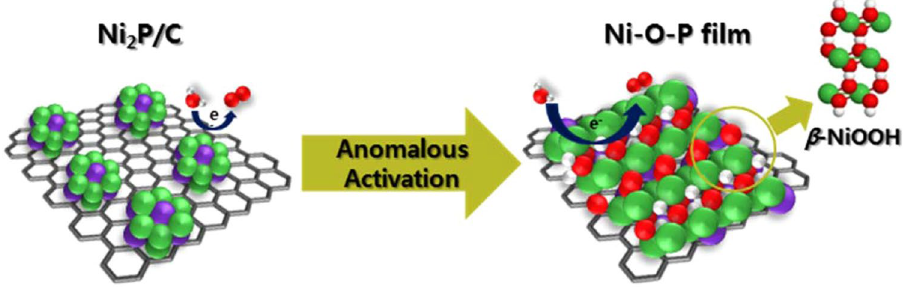
Figure 7. Schematic diagram of the anomalous in situ transformation of Ni 2 P to β -NiOOH for a robust OER